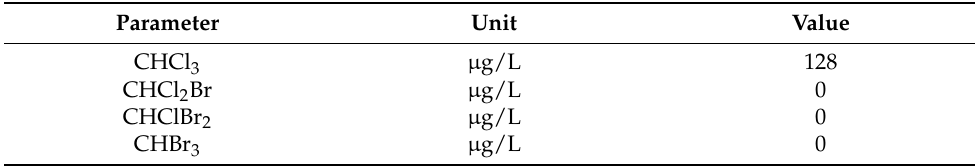
Table 2. The number of THMs formed during the electrochemical oxidation under the